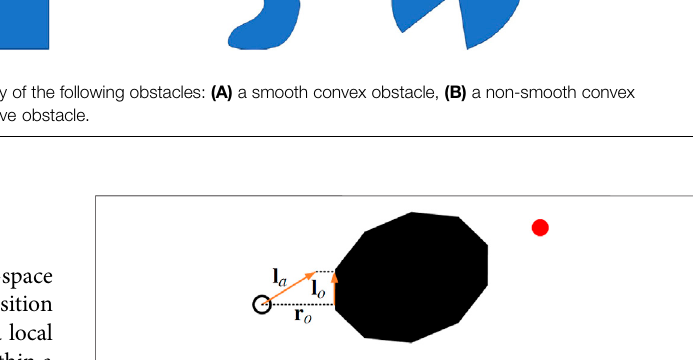
FIGURE 3 | The workspace of a robot on its way towards the target in the close proximity of the polygonal obstacle. The arti fi cial current on the surface of obstacle l o is designed to have the same direction as the projection of the robot ’ s velocity l a on to the obstacle